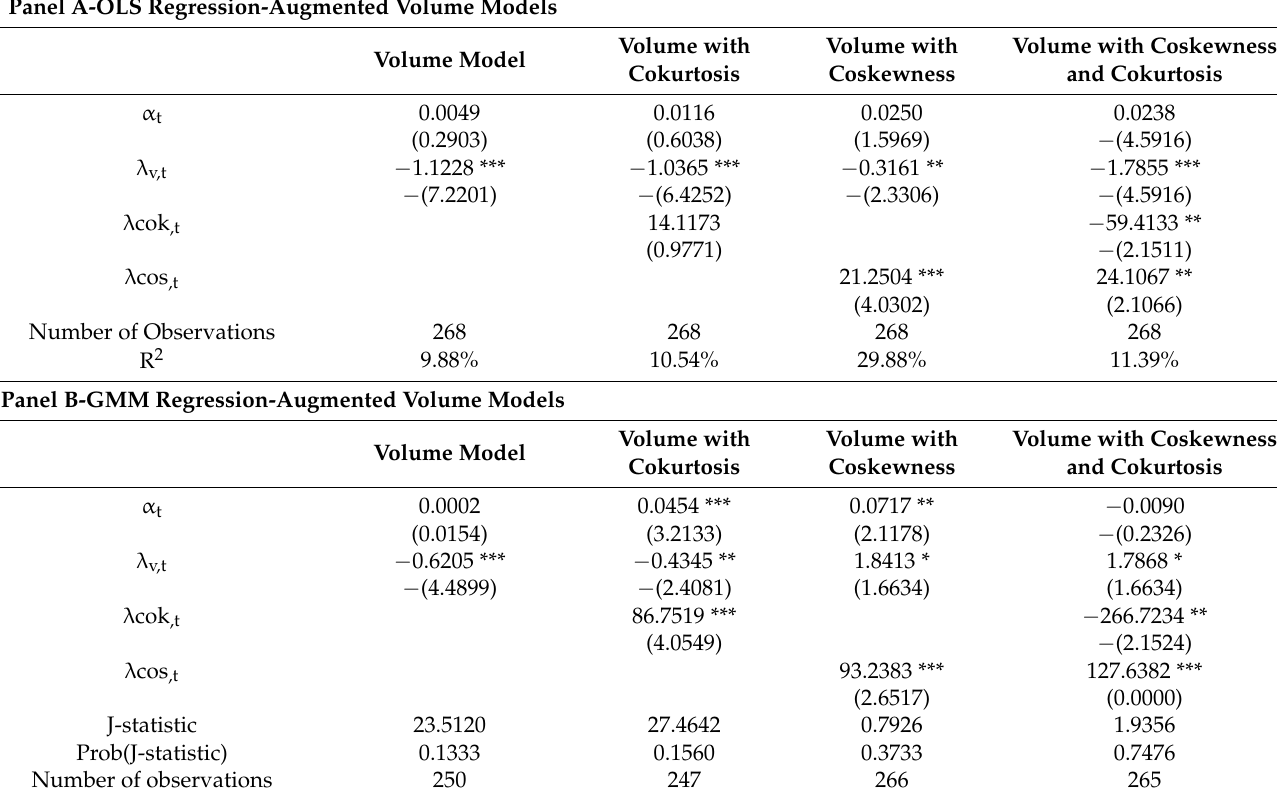
Table 2. Different augmented volume models with cokurtosis and coskewness for monthly returns of Colombian electricity spot